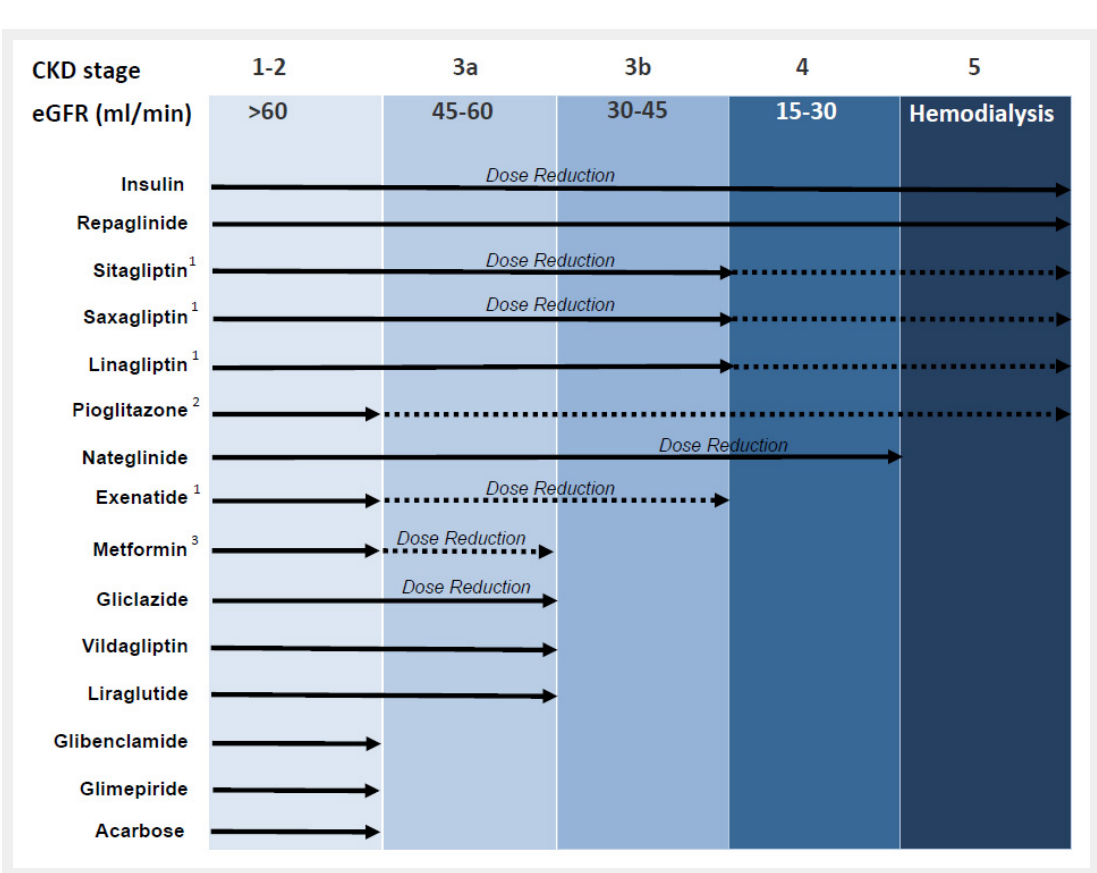
Figure 1 Antidiabetic treatment in chronic renal failure according to the KDIGO staging of CKD. Adapted from: Schernthaner G, Ritz E, Schernthaner GH. Strict glycaemic control in diabetic patients with CKD or ESRD: beneficial or deadly? Nephrol Dial Transplant. 2010;25:2044–7 [25] (© 2010, Oxford University Press. Reprinted with permission). Recommendations adapted to stages of CKD based on a consensus from pharmacological data, Swiss and international recommendations. 1 Limited experience (dotted line); 2 monitor for fluid retention; 3 avoid introducing as new therapy or if conditions increasing lactic acidosis